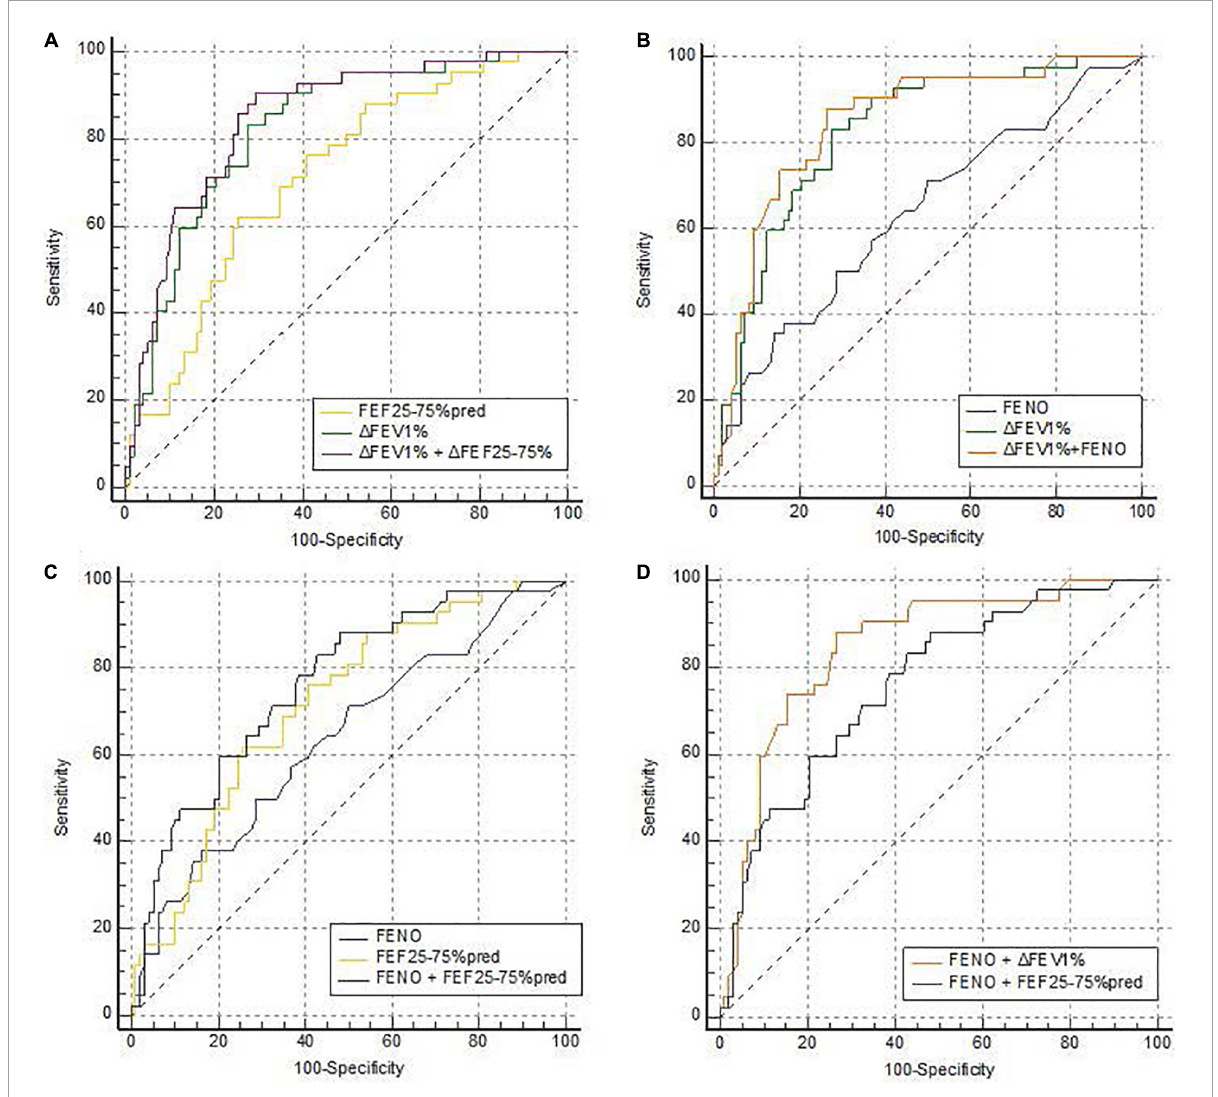
FIGURE1 ROC curves of the joint models predicting CVA diagnosis. ROC curves for the joint models of (A) (cid:49) FEV 1 % and FENO, (C) FENO and FEF 25 - 75 %pred, (B) (cid:49) FEV 1 % and FEF 25 - 75 %pred, and (D) compare the AUC of FENO + (cid:49) FEV 1 % and FENO + FEF 25 - 75 %pred in predicting CVA. (A) n = 140; AUC (cid:49) FEV 1% + FENO = 0.847 (95% CI, 0.778 to 0.916); AUC FENO = 0.637 (95% CI, 0.535 to 0.739); AUC (cid:49) FEV 1% = 0.825 (95% CI, 0.752 to 0.897). (C) n = 140; AUC FENO + FEF 25 - 75% pred = 0.762 (95% CI, 0.677 to 0.847); AUC FENO = 0.703 (95% CI, 0.601 to 0.805); AUC FEF 25 - 75% pred = 0.714 (95% CI, 0.624 to 0.804). (B) n = 140; AUC (cid:49) FEV 1% + FEF 25 - 75% pred = 0.848 (95% CI, 0.779 to 0.916); AUC (cid:49) FEV 1% = 0.825 (95% CI, 0.752 to 0.897); AUC FEF 25 - 75% pred = 0.714 (95% CI, 0.624 to 0.804). CVA, cough variant asthma; (cid:49) FEV 1 %, the increase in forced expiratory in 1 s as a percentage of baseline value in a bronchodilation test; FEF 25 - 75 %pred, percentage of predicted forced expiratory flow at 25% to 75%; FENO, fractional exhaled nitric oxide; ROC, receiver operating characteristic; AUC, area under the